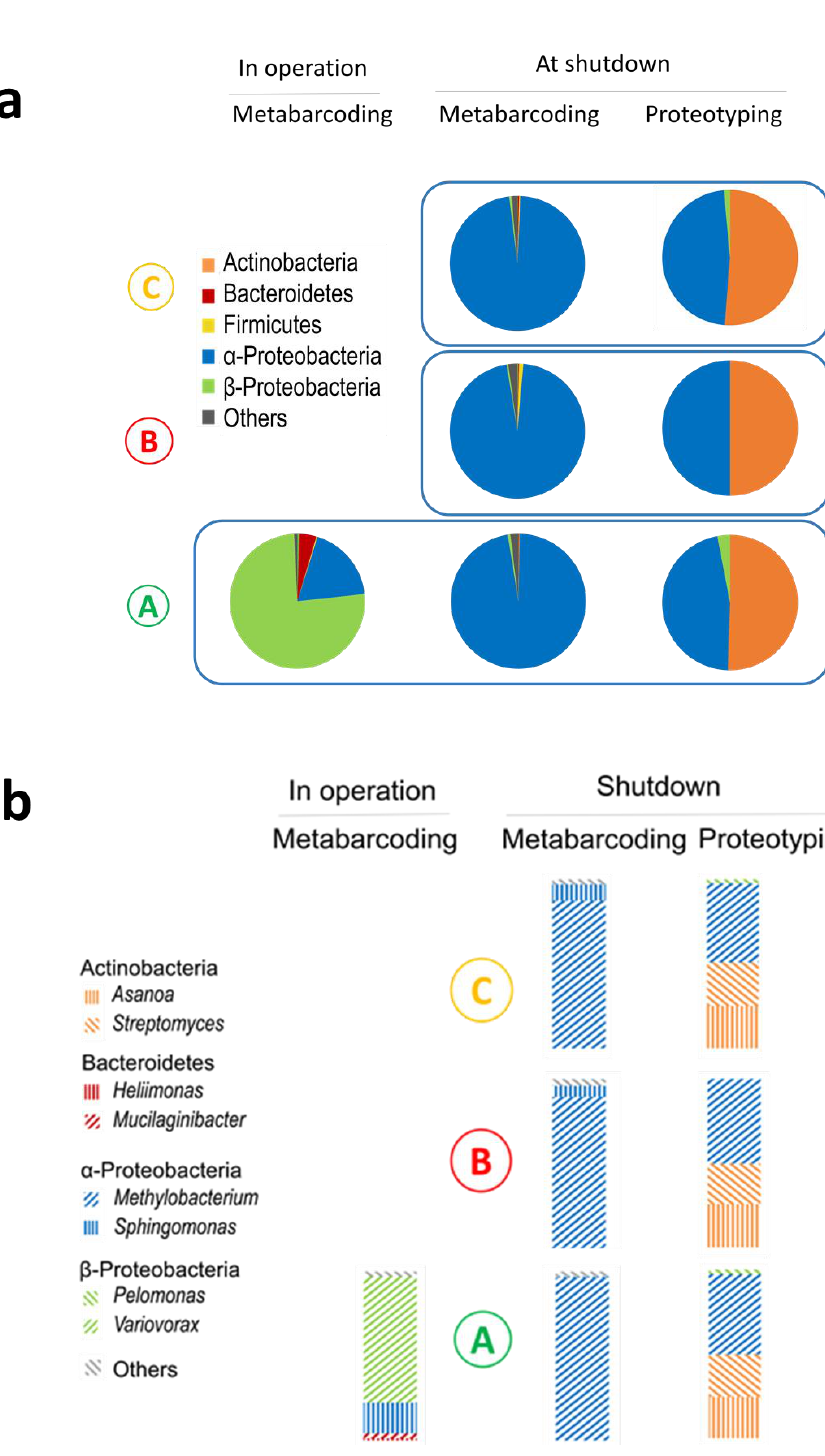
Figure 2. Microbial communities present in the cooling pool of the Osiris nuclear reactor core. ( a ) Main phyla (class for Proteobacteria) and ( b ) main genera (abundance above 1%) detected in operation and at shutdown using metabarcoding and proteotyping. Mean taxon abundance obtained by the different methods (see Materials and Methods section).